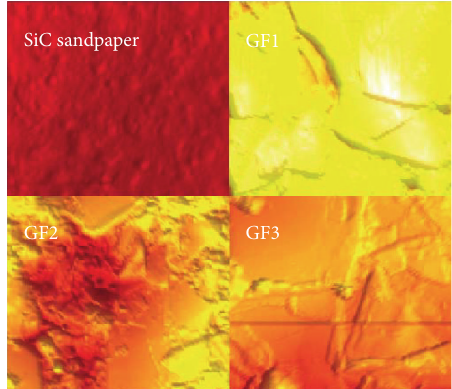
Figure 3: AFM images of samples with graphite assembled of dif- ferent thickness. As reference, the AFM image of SiC sandpaper is shown.